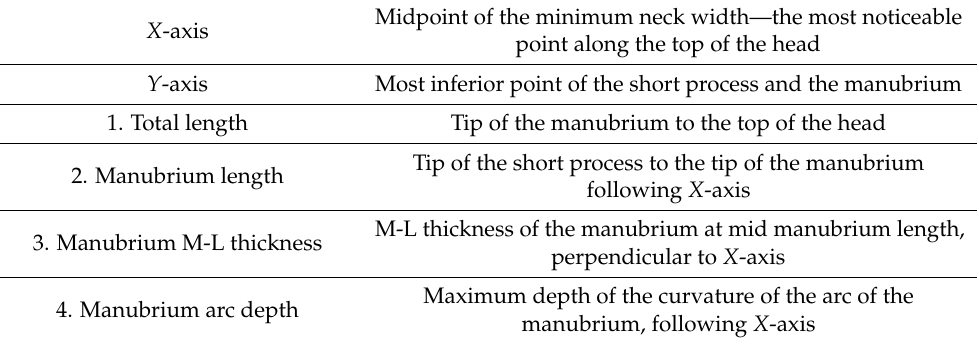
Table 1. Measurement protocol and indices for the malleus [5]. Midpoint of the minimum neck width—the most noticeable X -axis point along the top of the head Y -axis Most inferior point of the short process and the manubrium 1. Total length Tip of the manubrium to the top of the head Tip of the short process to the tip of the manubrium 2. Manubrium length following X -axis M-L thickness of the manubrium at mid manubrium length, perpendicular to X -axis Maximum depth of the curvature of the arc of the manubrium, following X